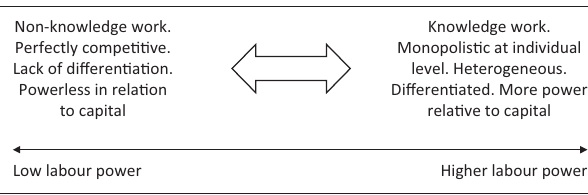
FIGURE 2: The knowledge work/non-knowledge work